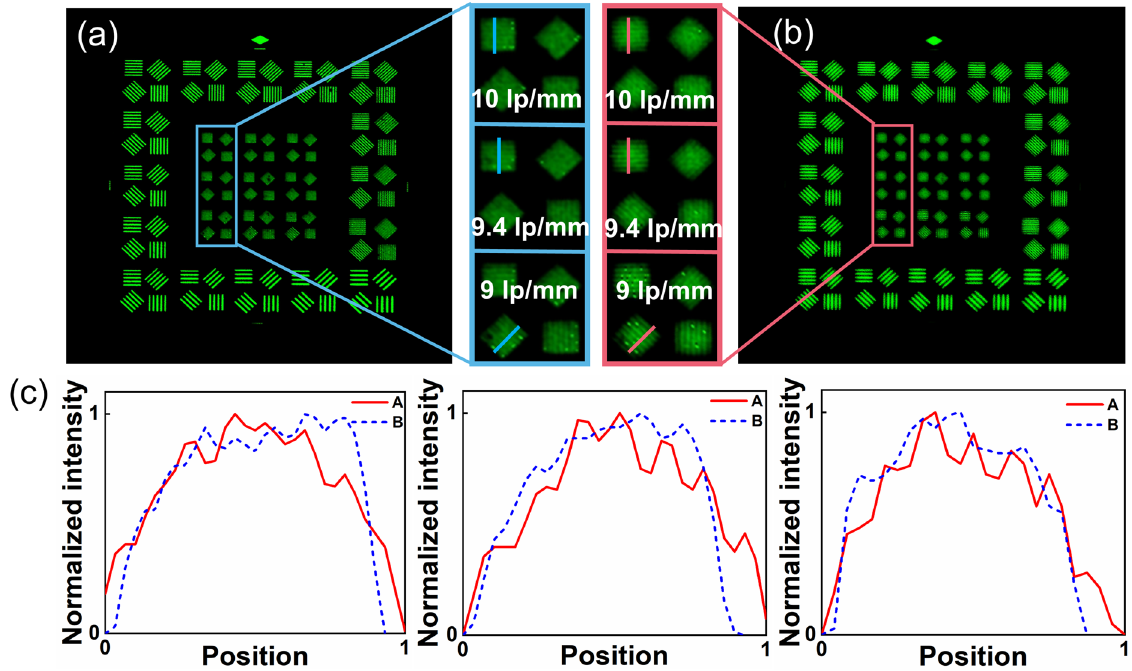
Figure. 5. Resolution testing of the long focus. ( a ) Resolution image taken by the refractive lens. ( b ) Resolution image taken by the BDL. ( c ) Grayscale visualization curves of the small target images (A: BDL, B: Refractive Lens).